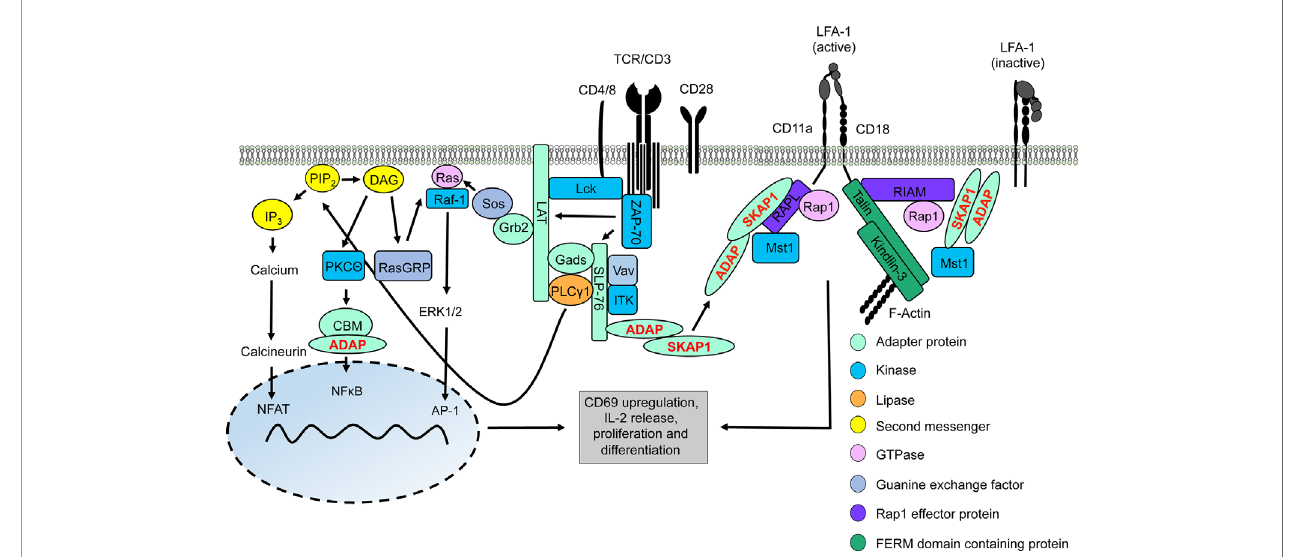
FIGURE 1 | TCR/CD3 machinery leading to gene regulation and integrin activation. Upon TCR/CD3 complex stimulation, activated Lck phosphorylates ITAMs of the CD3 complex allowing recruitment and activation of ZAP-70. Active ZAP-70 phosphorylates the adapter proteins LAT and SLP-76, thus facilitating the formation of the LAT signalosome (includes LAT, SLP-76, Gads, Grb2, PLC g 1, ITK, ADAP, and SKAP1). ITK phosphorylates PLC g 1 which subsequently hydrolyses PIP 2 into DAG and IP 3 . IP 3 induces a signaling pathway for activation of the transcription factor NFAT into the nucleus whereas DAG activates two different transcription factors, NF k B (via the CBM/ADAP complex) and AP1 (Ras/ERK1/2 pathway). Translocation of these transcription factors into the nucleus facilitates T-cell